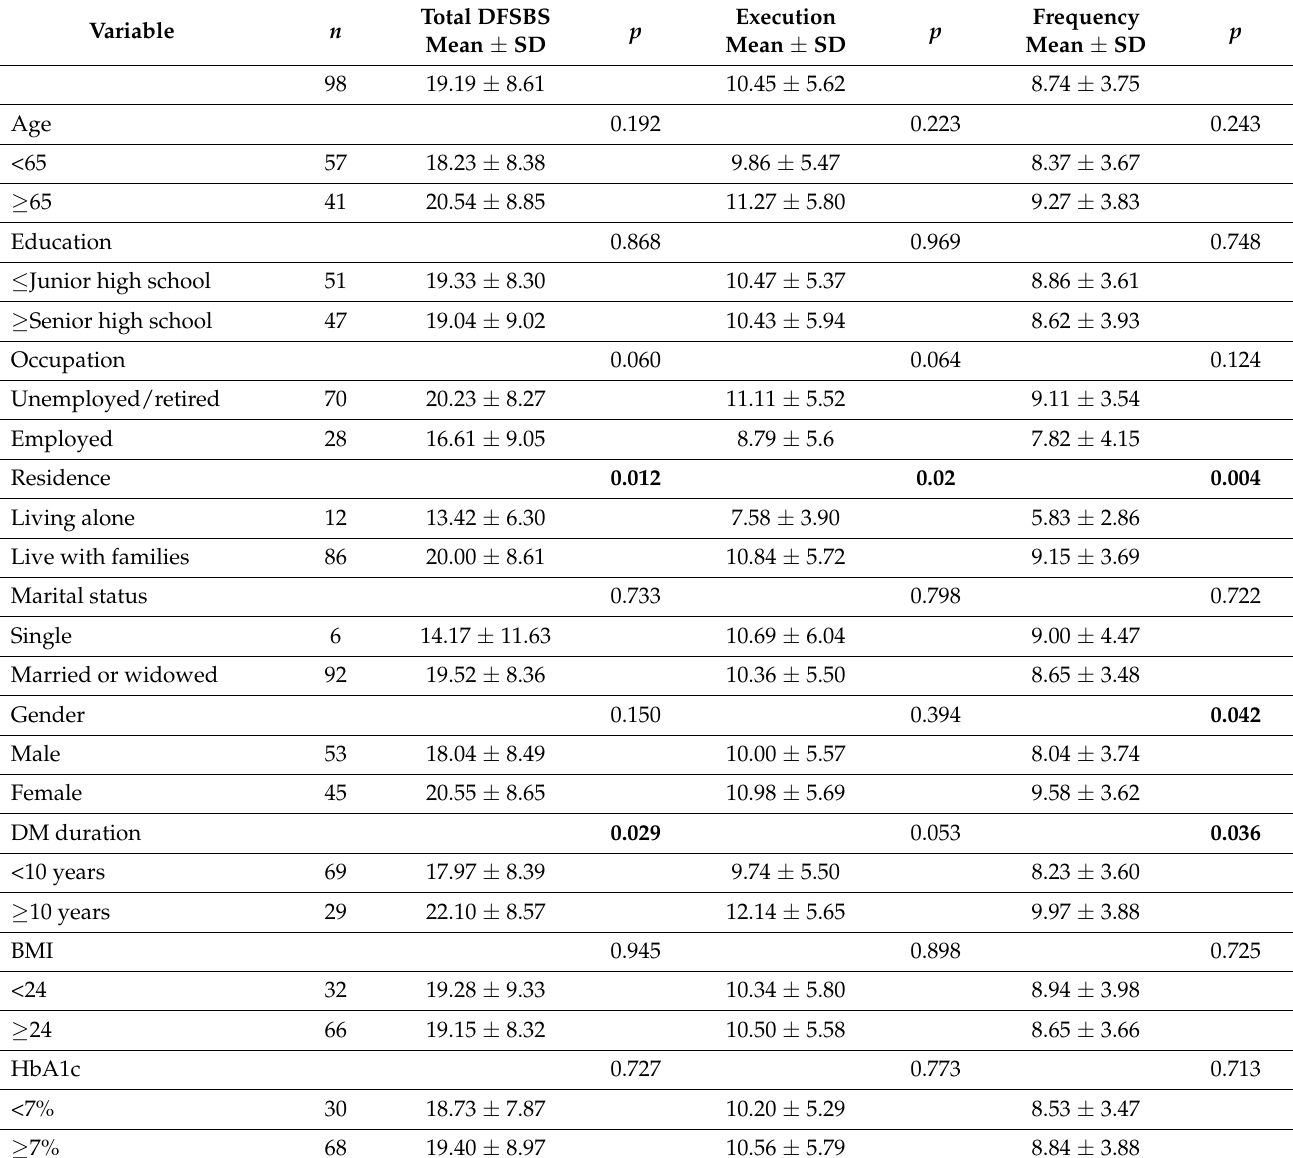
Table 1. Disparities of self-care DFSBS results among demographic and disease attribute